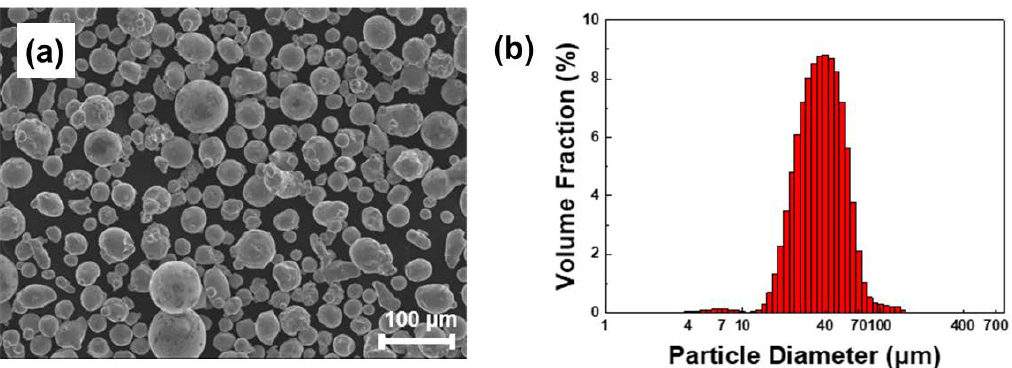
Figure 1. ( a ) Scanning electron microscope (SEM) image of maraging steel powder used for selective laser melting and ( b ) its particle size distribution.